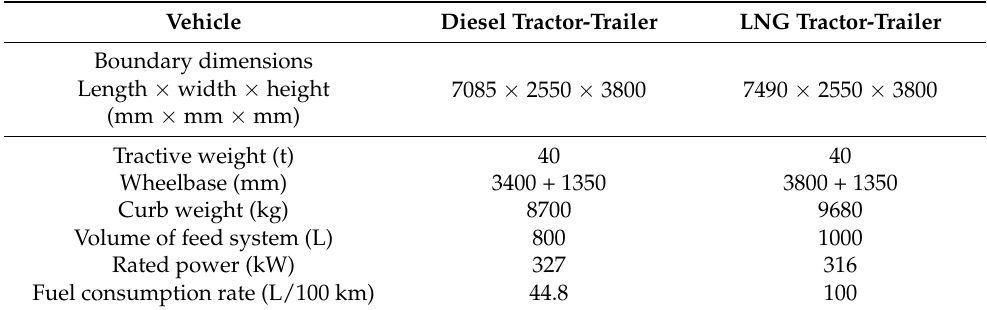
Table A1. Main technical and performance parameters of the CAMC tractor-trailer functional unit used in this study.